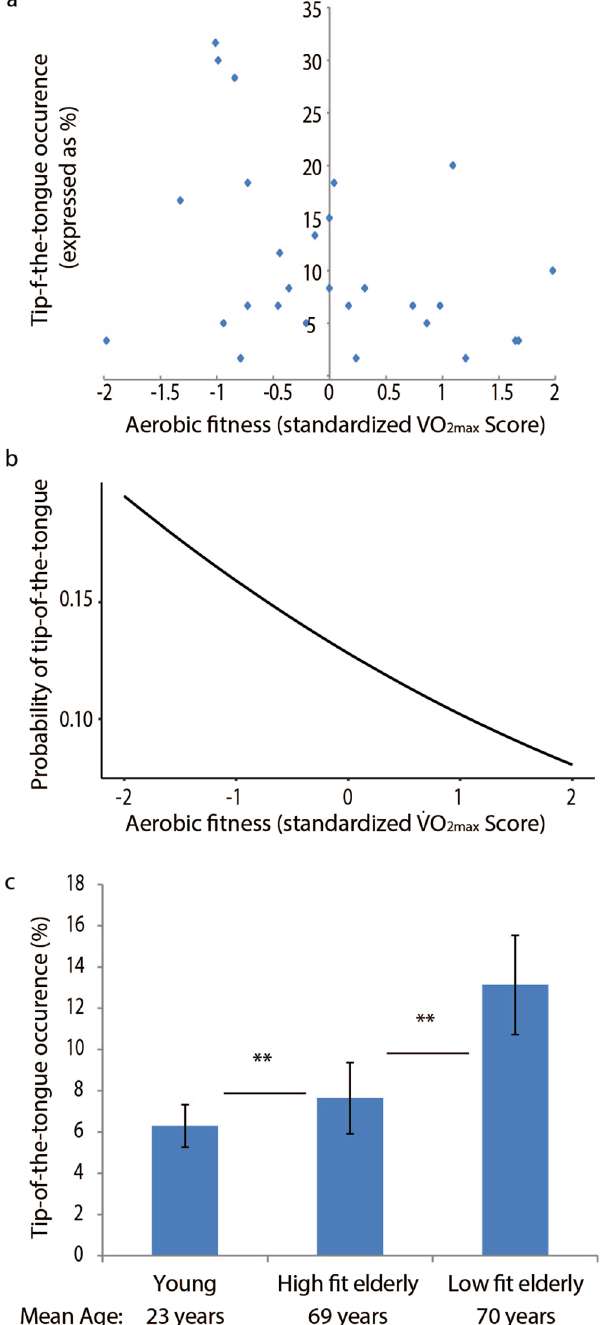
Figure 2. Aerobic fitness-related differences in word finding abilities. ( a ) Depicted for older adults is the tip-of- the-tongue occurrence as a function of standardized aerobic fitness scores. ( b ) There was a significant influence of the standardized aerobic fitness scores on the probability of experiencing a tip-of-the-tongue state. Depicted is the mean effect across participants, keeping all other variables in the model (see Table 2) constant. The higher the aerobic fitness score, the lower the probability of experiencing a tip-of-the-tongue state. ( c ) When the older adults were divided into groups of high- and low-fitness (high- and low-fit as determined by a median split, groups were matched for age, education level and vocabulary size), we found that low-fit older adults had a higher incidence of tip-of-the-tongue states than high-fit older adults. High-fit older adults in turn had a higher incidence than the young participants. Error bars represent standard error of the